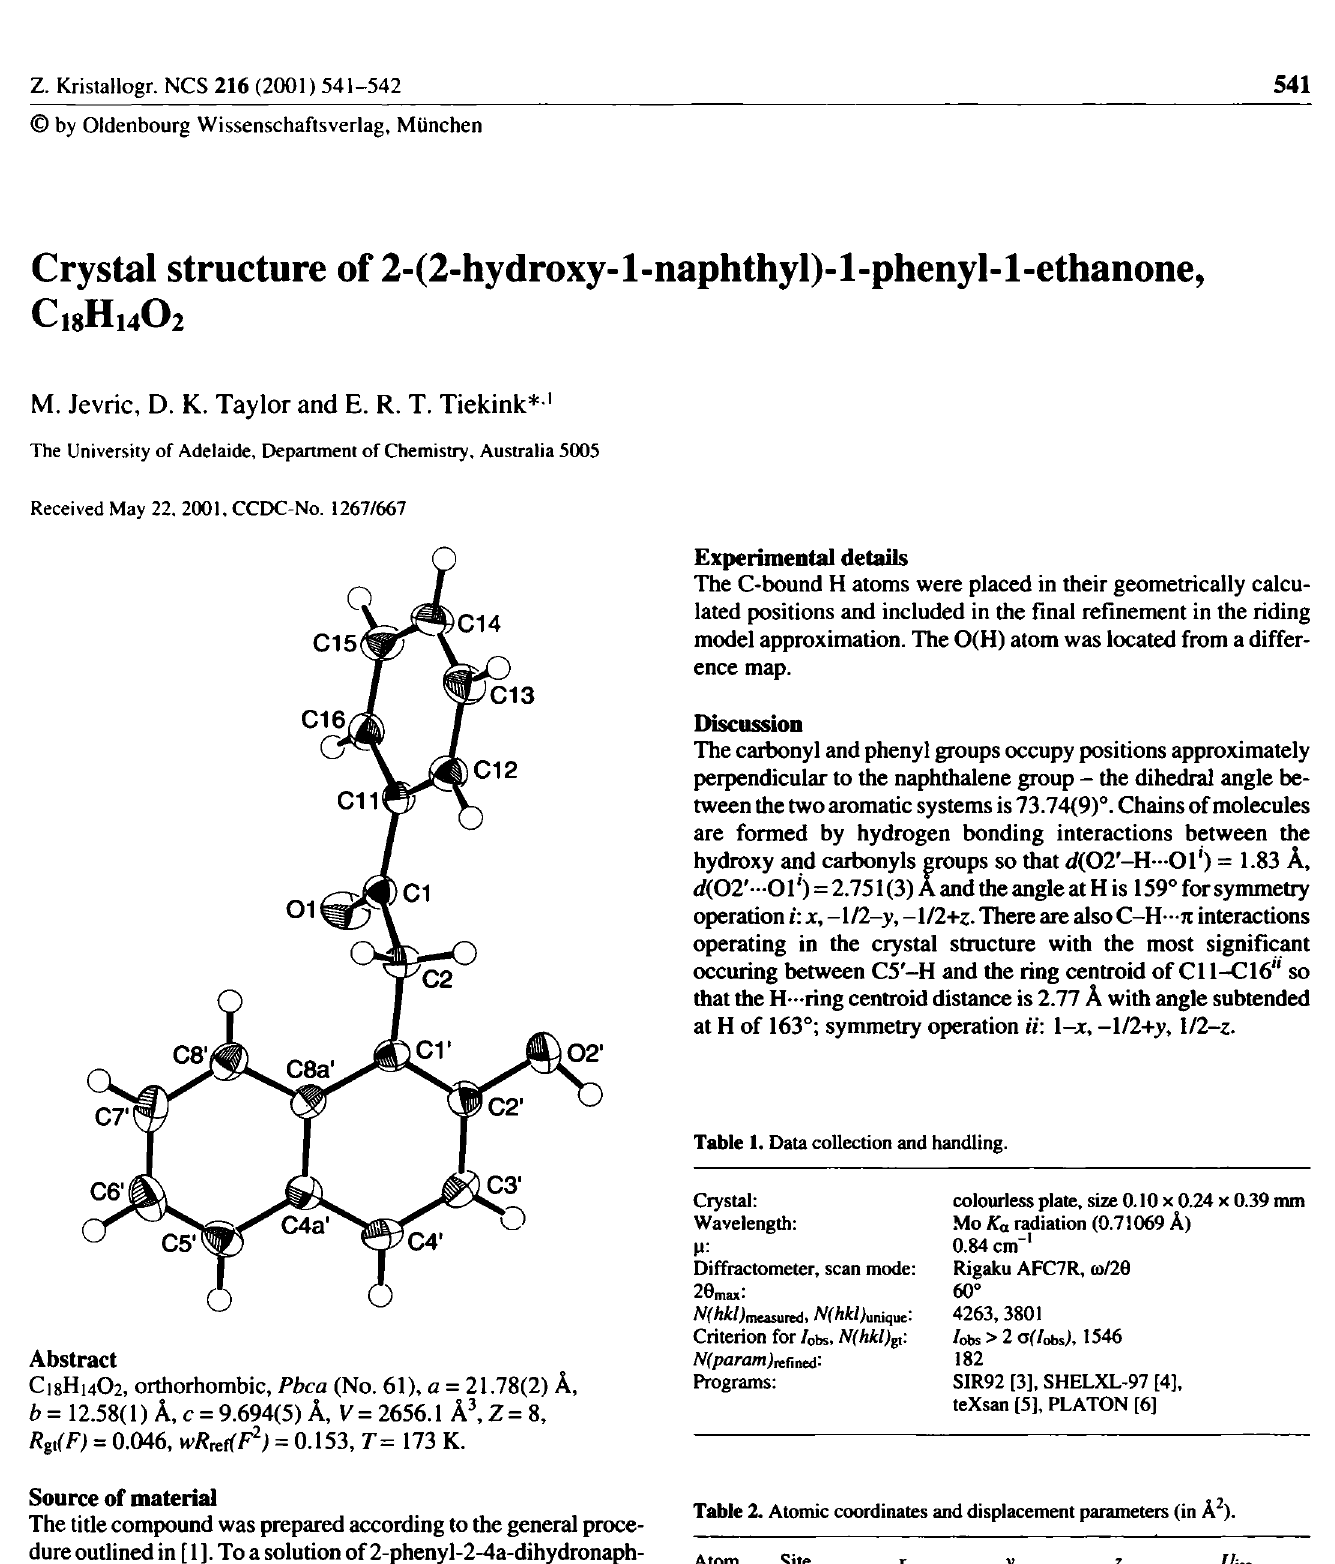
Table 2. Atomic coordinates and displacement parameters (in A 2